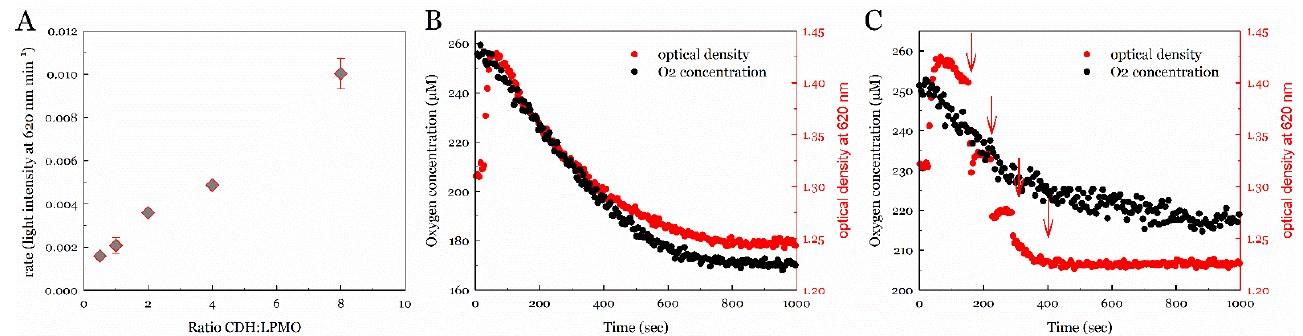
Figure 1. Decrease in attenuation in the turbidimetric assay of PASC depolymerization at pH 6.0 and 30°C. ( A ) Varying ratios of CDH in regard to 2 µM LPMO show a linear correlation of the obtained LPMO activities. ( B ) The decrease in optical density and oxygen concentration correlate and indicate that oxygen is directly or indirectly consumed during the reaction. ( C ) Repeated addition of 20 µM H 2 O 2 (red arrows) demonstrates that the fast degradation of PASC is correlated with the addition/production of H 2 O 2 .